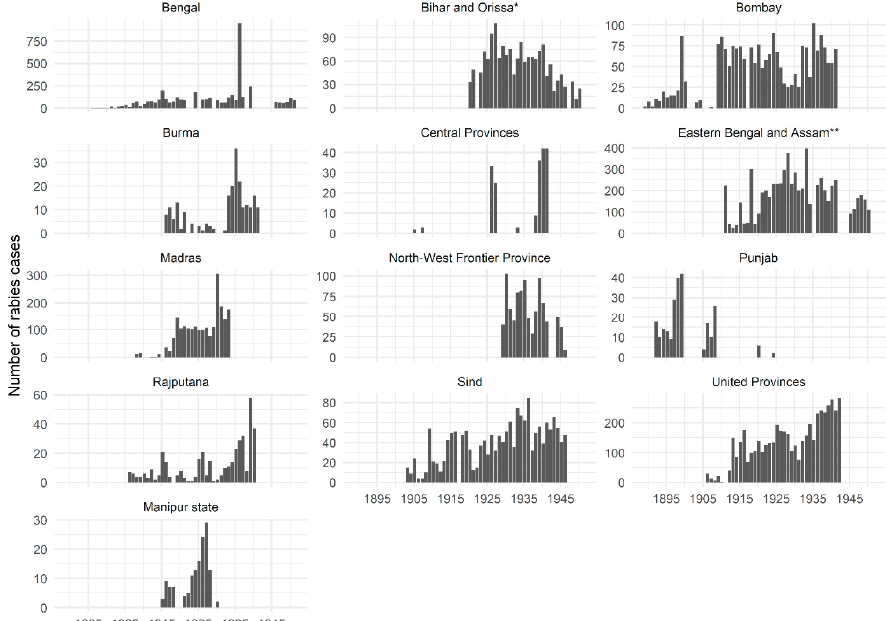
Figure 2. Annual rabies incidence in all animal species between 1887 and 1951 (annual data span April to the following March, e.g., April 1887 to March 1888) in every British province in India (except Baluchistan for which no data were available) and the princely state of Manipur. Statistics were compiled from annual reports of the Civil Veterinary Department of the colonial British Government of India, available at https://digital.nls.uk/indiapapers/. Note the different scale of the y -axis for each region. * 1911 – 12 to 1935 – 36 — Bihar and Orissa provinces, 1936 – 37 to 1949 – 50 — Bihar only; ** 1907 – 08 to 1910-11 — Eastern Bengal and Assam provinces, 1912 – 13 to 1949-50 — Assam only.